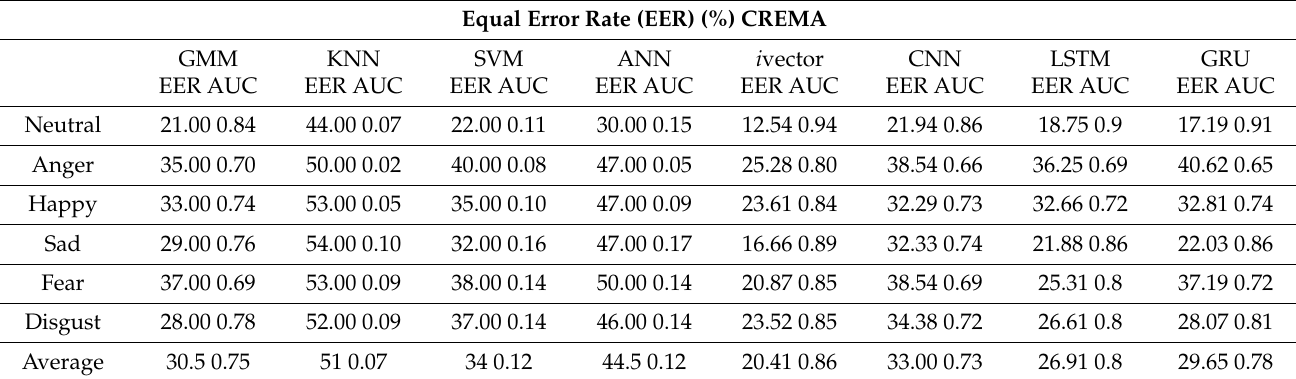
Table 4. Percentage EER and AUC scores using the CREMA